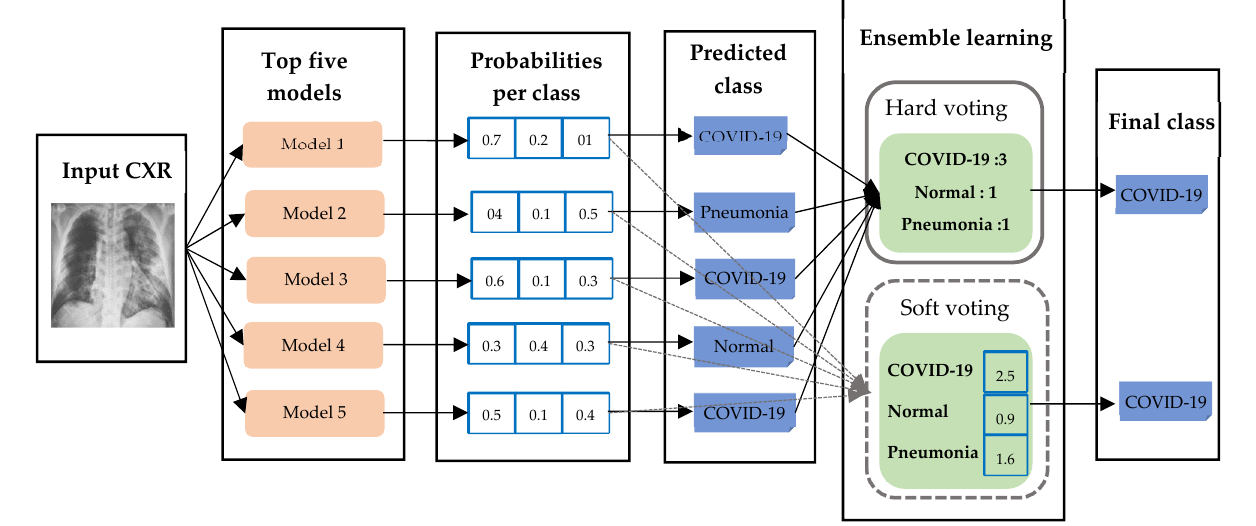
Figure 14. Ensemble learning using majority hard voting and soft voting.